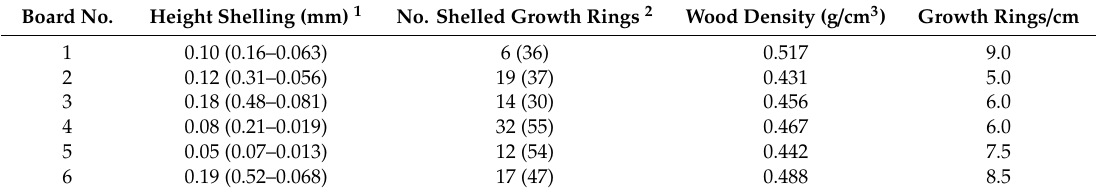
Table 2. Wood properties and shelling of six di ff erent flat western larch deckboards oriented pith-side-up and exposed to the weather in Vancouver, BC, Canada for 7 months. Board